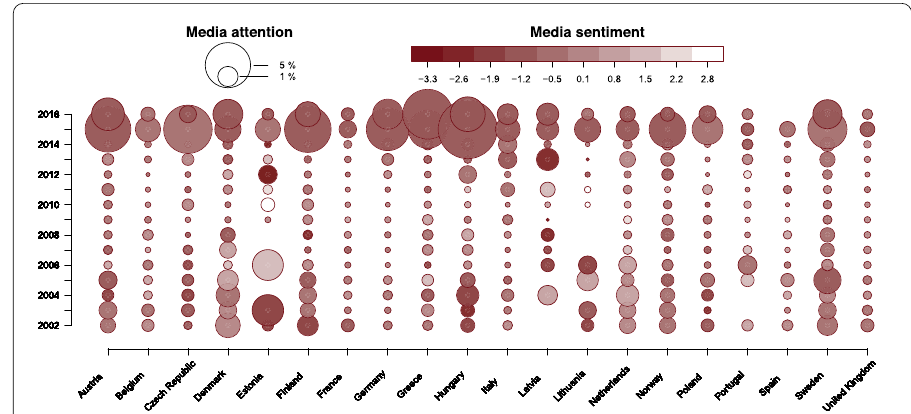
Figure 5 Measure of public debate in the media across Europe. Illustration of public debate sentiment and attention in the media on refugees from 2002–2016 for each European country in our study. Mediaattention : relative number of articles covering refugee-related vs. other events in a given country. Mediasentiment : the mean sentiment of refugee-related events minus the mean sentiment of all events in a given country. Formal definitions provided in the main